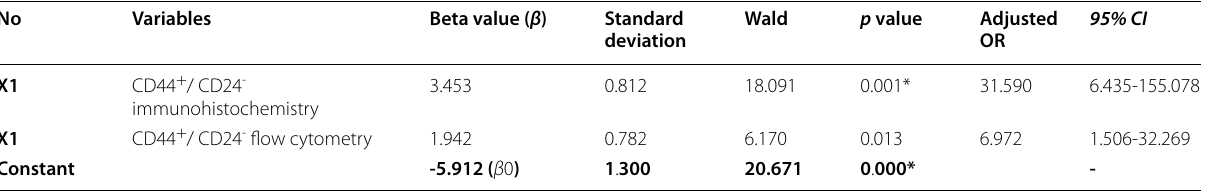
* p < 0.05, significant